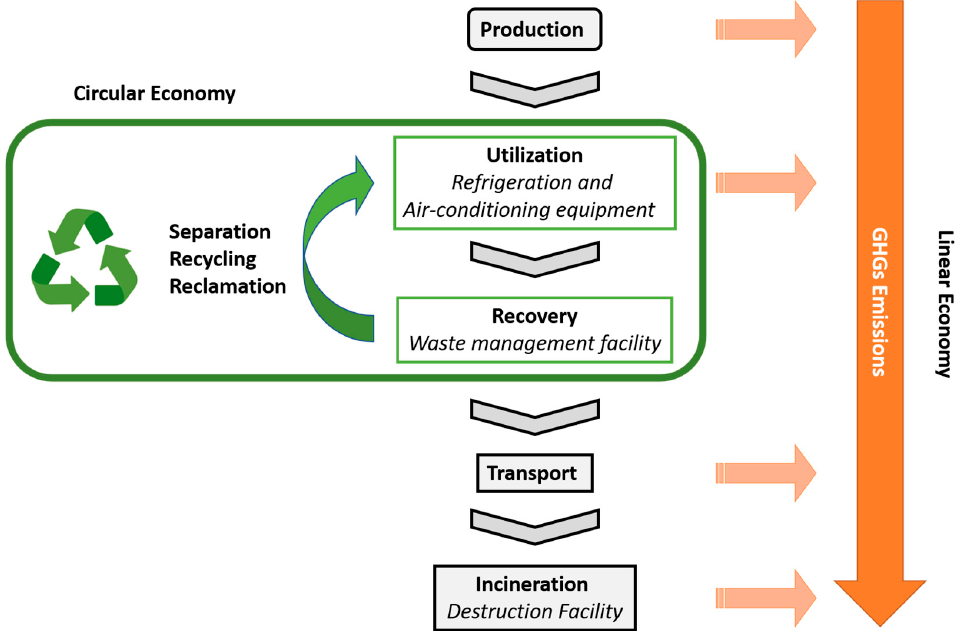
Figure 2. Possible approaches for the management of F-gases, following either a linear economy concept (from production to incineration) or a circular economy concept (involving separation, recycling and/or reclamation processes).